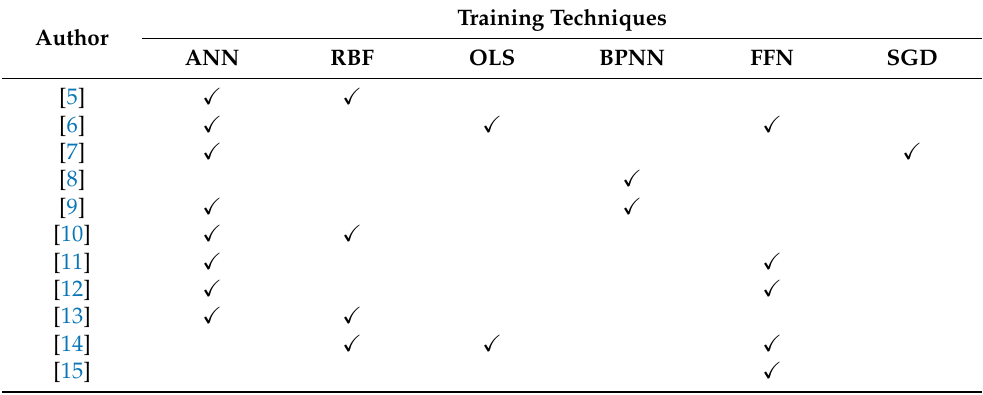
Table 1. Summary of techniques commonly used in the training of time series